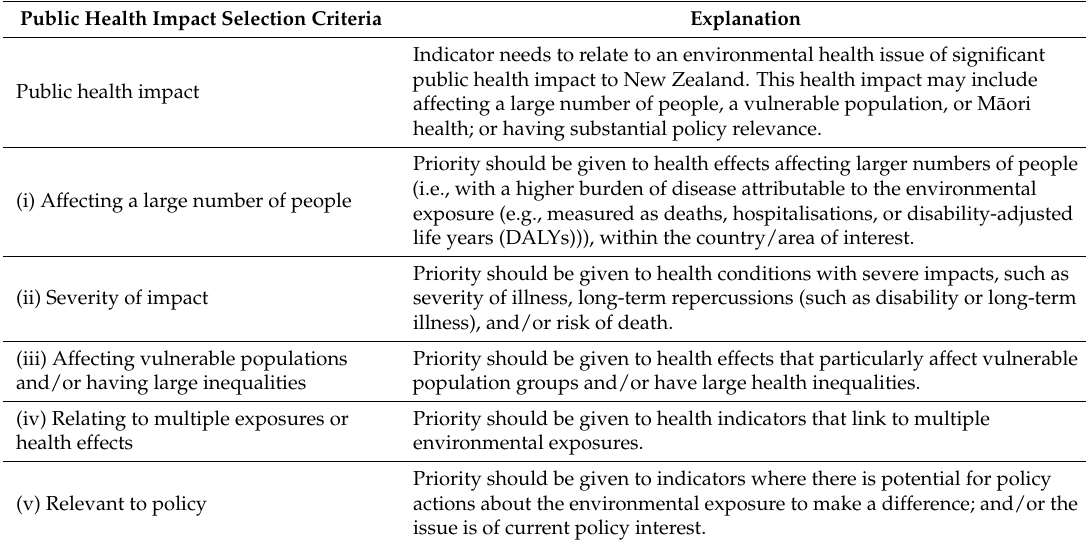
Table 2. Public health impact criteria for environmental health